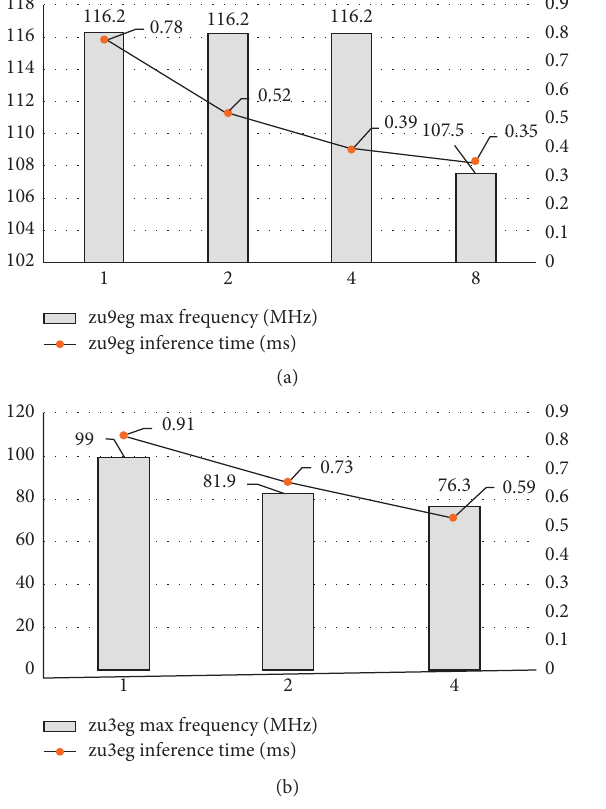
Figure 11: Max frequency and inference time for the Zynq-US+ family.